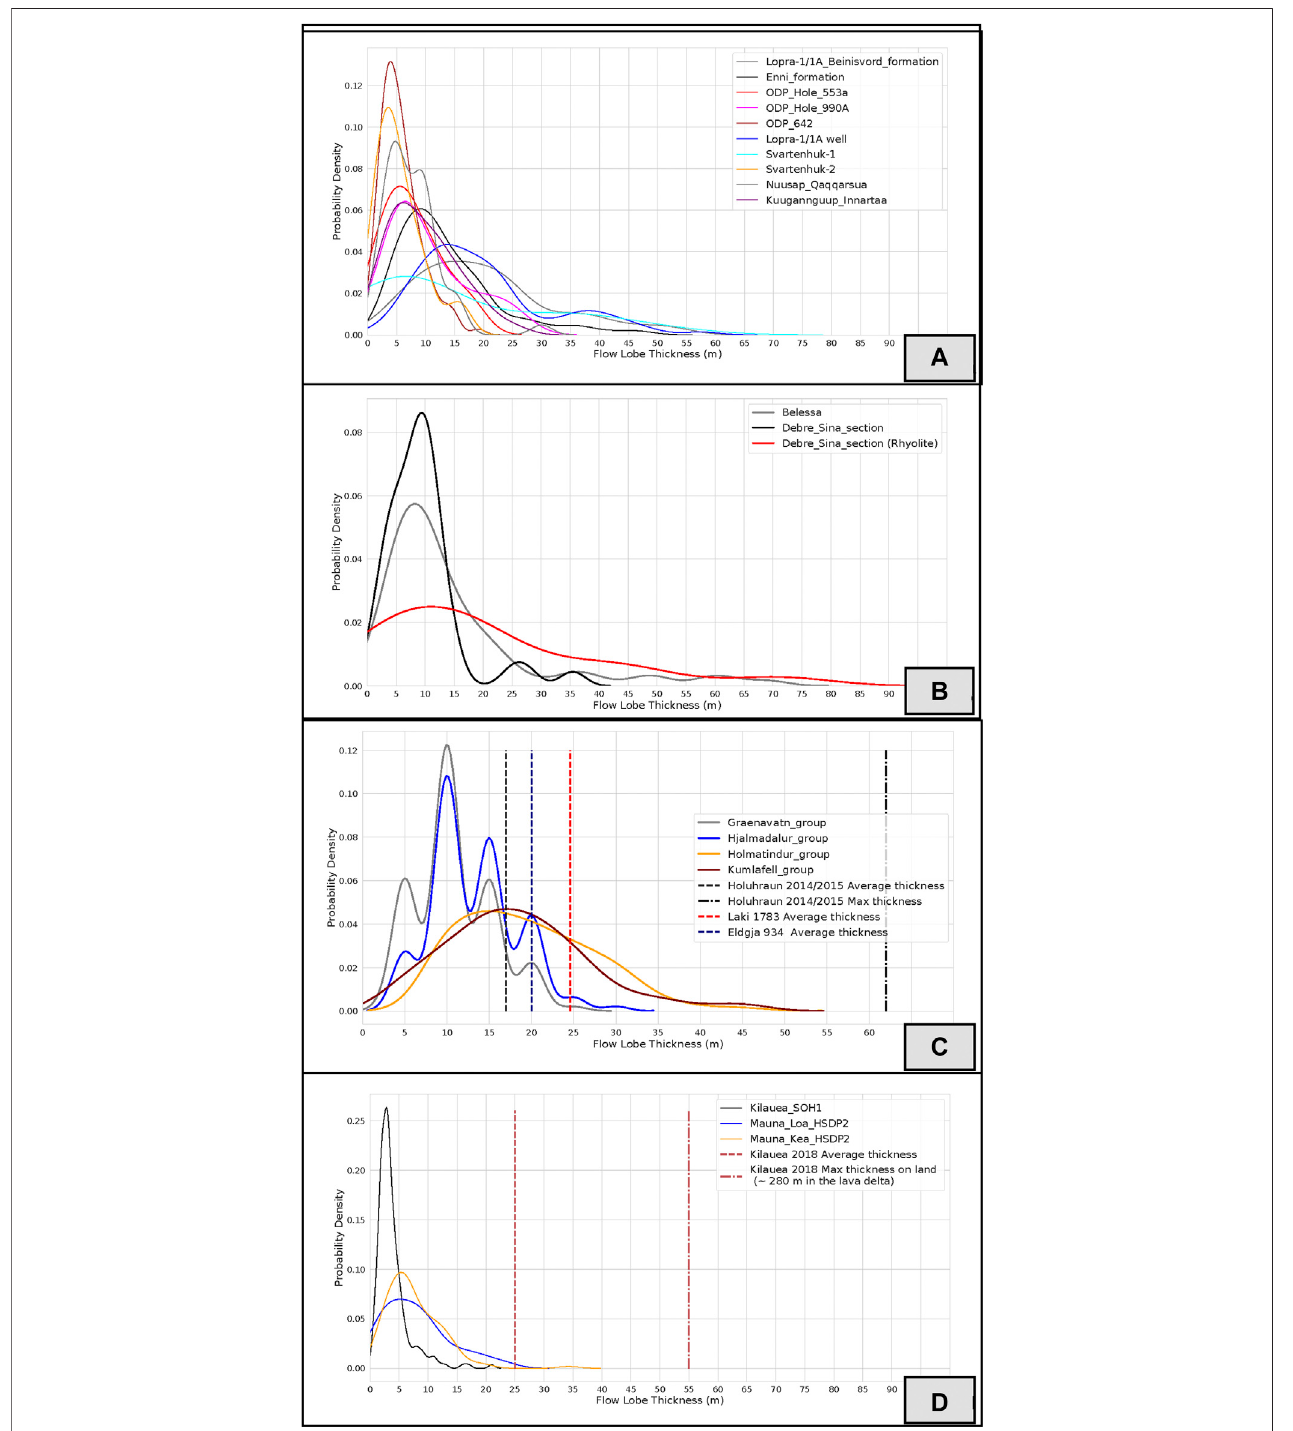
FIGURE 10 | (A) Plot of univariate kernel density estimators to calculate PDF of lobe thicknesses for NAIP formations in Faroe Islands, West Greenland, and the NorthSea fl oor(ODPdata);seetextfordetails. (B) PlotofunivariatekerneldensityestimatorstocalculatePDFoflobethicknessesforlavasfromEthiopianTraps;seetext for details. (C) Plot of univariate kernel density estimators to calculate PDF of lobe thicknesses for lavas from the Neogene Flood Basalt Province in Iceland along with typical fl ow lobe thickness for a few modern eruptions. See text for details. (D) Plot of univariate kernel density estimators to calculate PDF of lobe thicknesses for lavas from island of Hawa ’ i, including Mauna Loa, Mauna Kea, and K (cid:1) ilauea. See text for details.